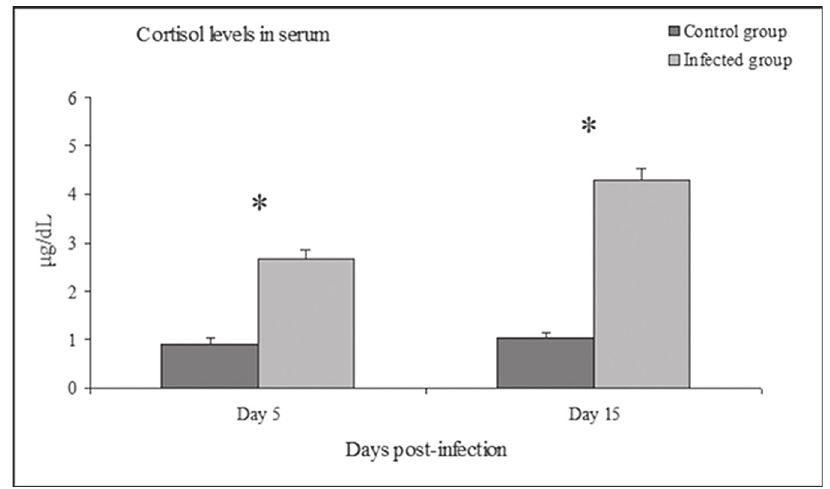
Figure 2 - Serum cortisol levels in rats experimentally infected with Trypanosoma evansi on days 5 and 15 PI compared to uninfected animals (Student: * P